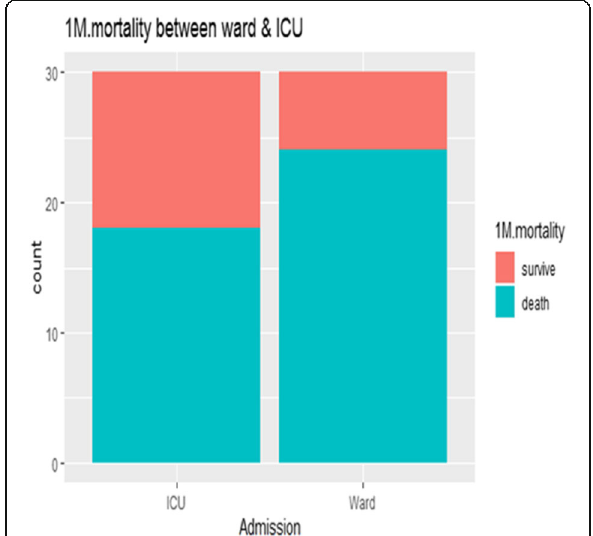
Fig. 5 1M. mortality between the ward and ICU groups. Figures 5 and 6 show that there is a non-significant difference between ward and ICU regarding 1M. and 3M. mortalities